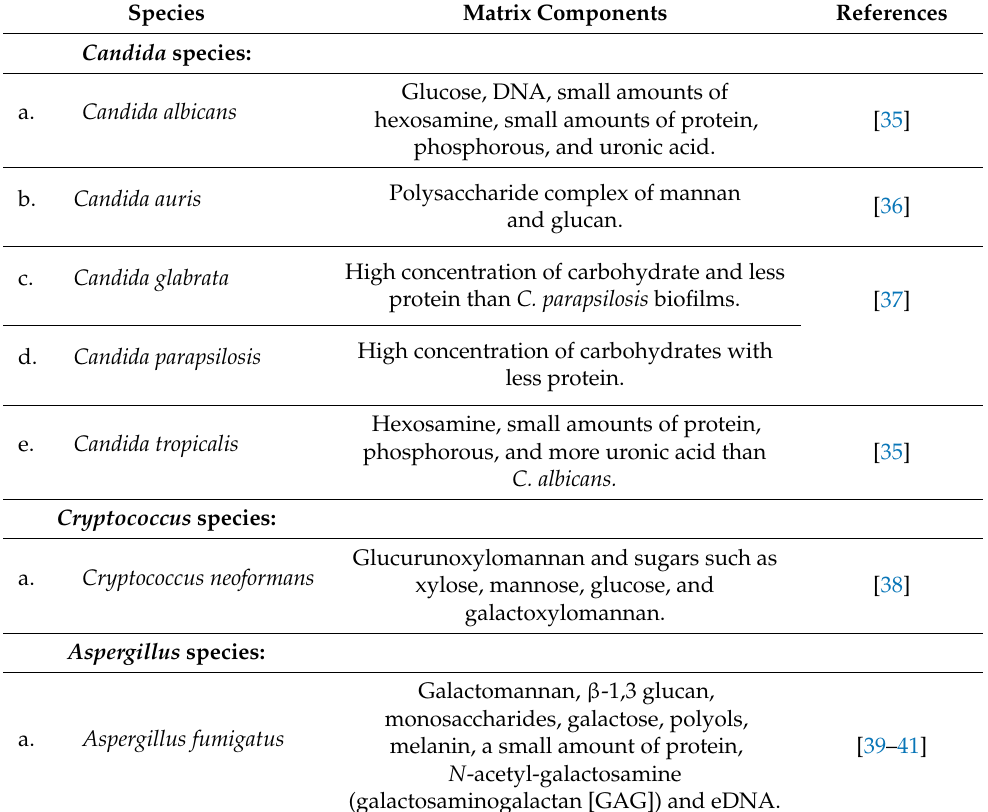
Table 1. Fungal biofilms and their matrix components.